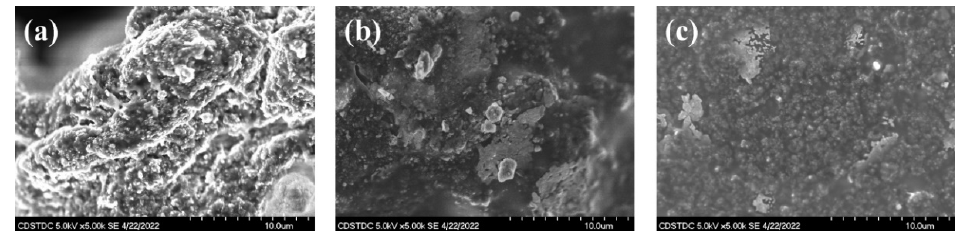
Figure 3. SEM images of modified samples 3 ( a ), 5 ( b ) and 6 ( c